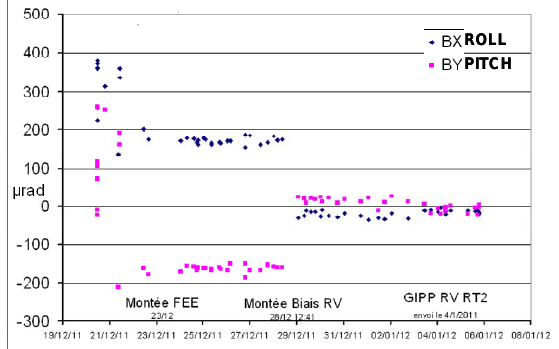
Figure 6 Misalignments improvement at the beginning of life The pointing performance were measured by comparing the request up to the satellite and the location given by the model shooting. This performance is much better than the specification because of the very good prediction and measurement of the orbit: 80 m to 90% since the 311PdV on 05/01/2012. And even with the beginning of life since 20/12 (428PdV), they are of 128 meters at 90%